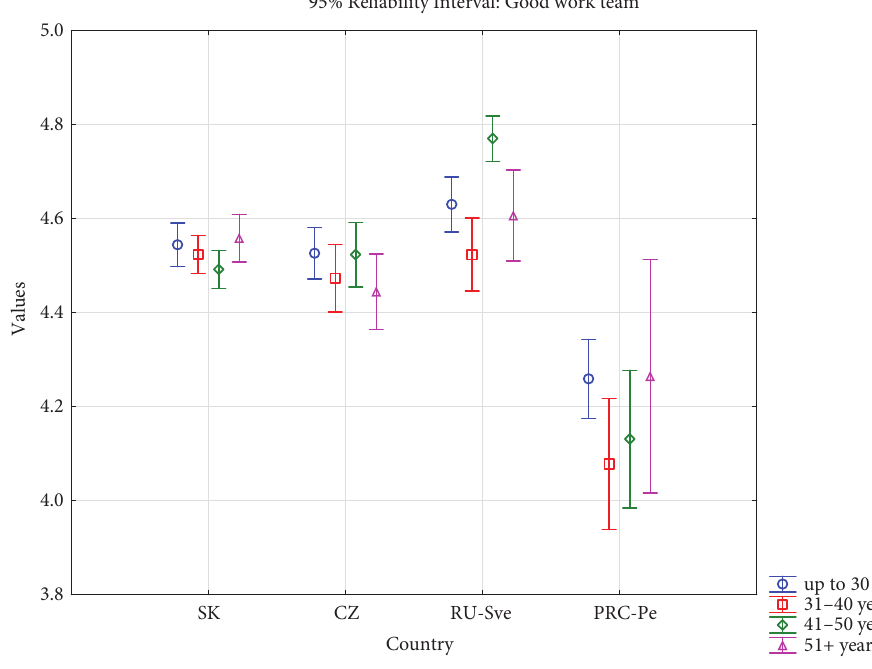
Figure 4. “Good work team” interactions and age